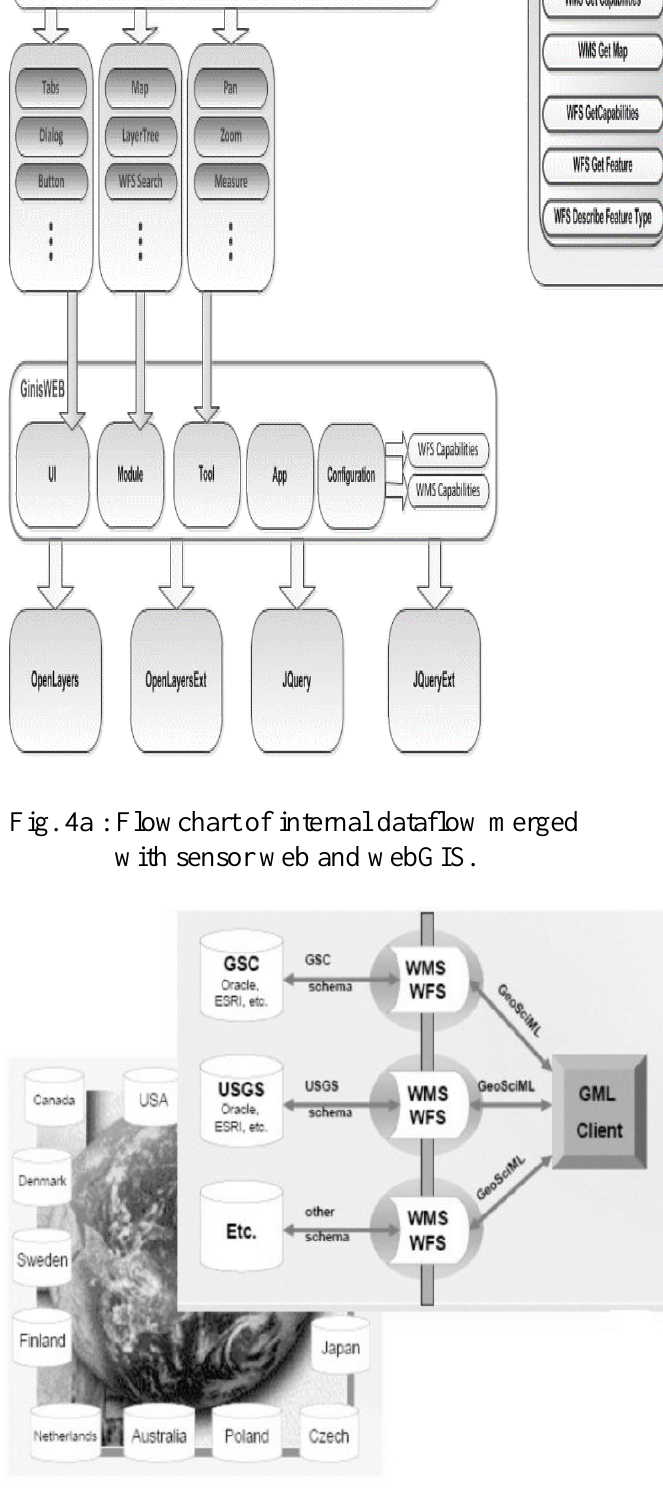
Fig. 4b : Sample integrated sensored webGIS GeoSciML is being worked on by EU